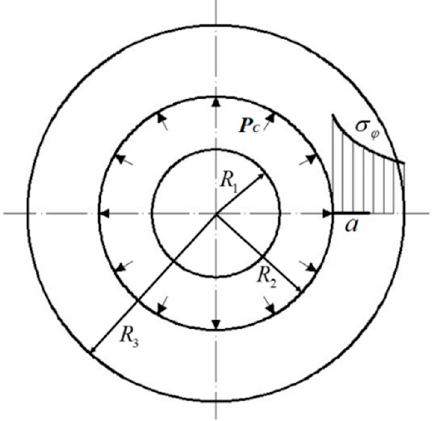
Figure 1. Two thick-walled cylinders with a radial crack.